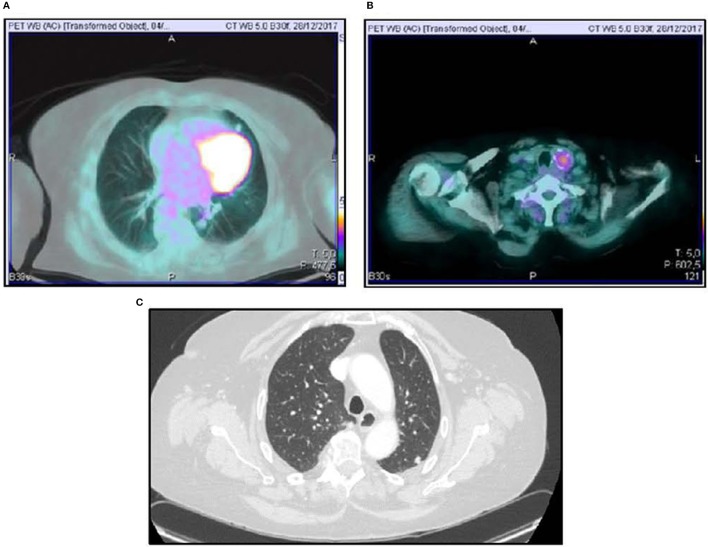
18FDG-PET scan showing lung uptake (A) and thyroid uptake (B). Computed Tomography Imaging of lung metastasis (C).